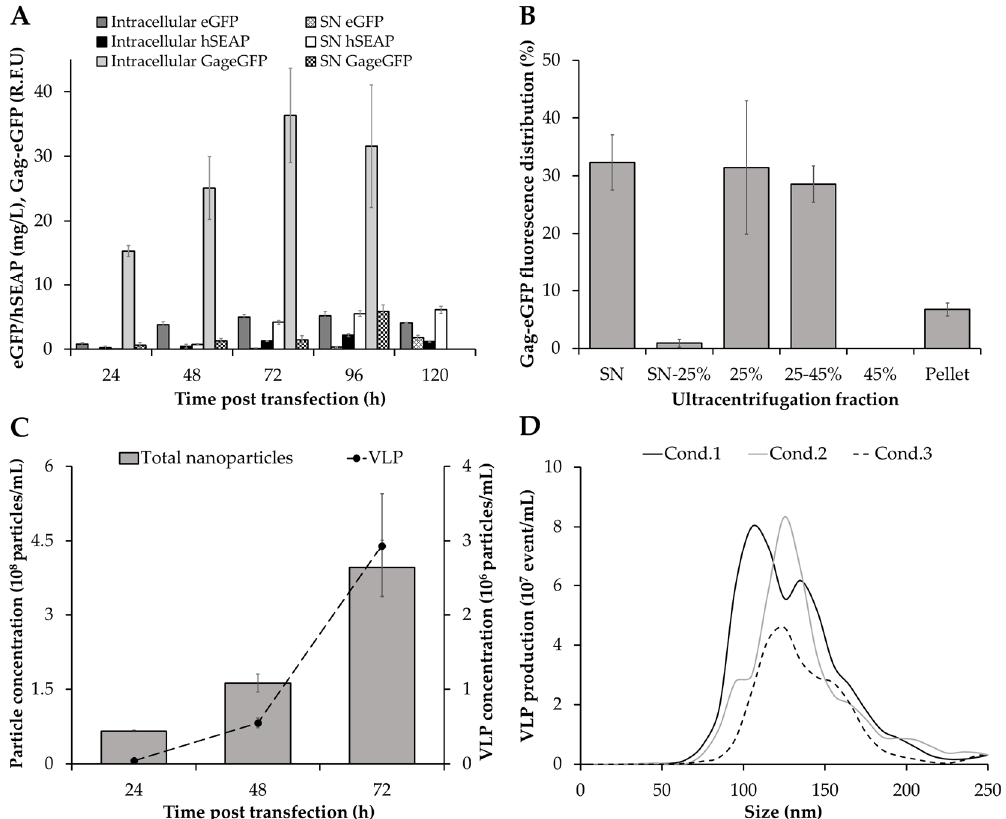
Figure 2. Recombinant protein production in transfected High Five cells cultured in shake flasks. ( A ) Intra- and extracellular production of eGFP, hSEAP and Gag-eGFP. ( B ) Fluorescence distribution of Gag-eGFP by spectrofluorometry in supernatants harvested at 72 hpt after double sucrose cushion ultracentrifugation. ( C ) Analysis of the nanoparticle production process by flow virometry. ( D ) Assessment of VLP size distribution by nanoparticle tracking analysis at 72 hpt. The average values